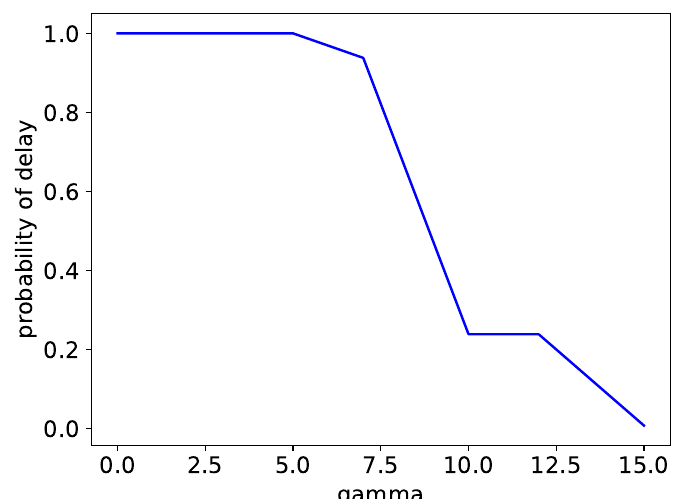
Figure 6. Trade-off between gamma and probability of